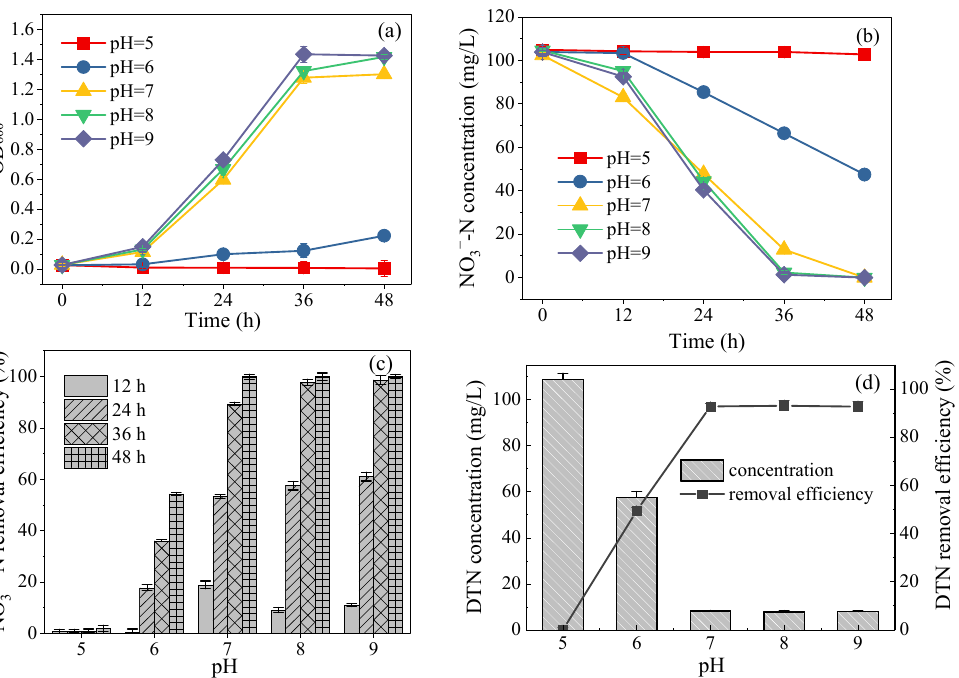
Figure 6. Effect of initial pH on nitrogen removal by strain 41. ( a ) Growth curves of strain 41; ( b ) variation of NO 3 − -N concentration; ( c ) removal efficiency of NO 3 − -N; ( d ) characteristics of DTN removal.